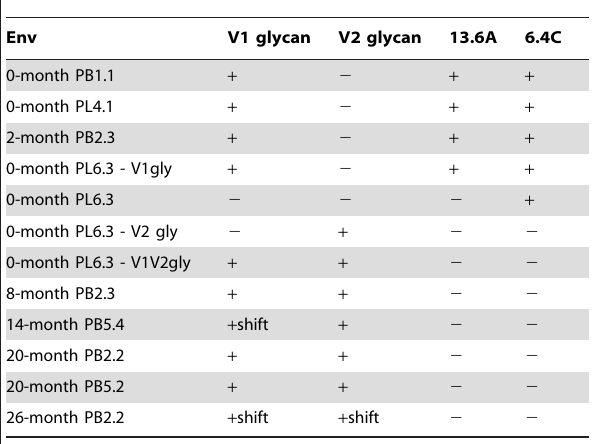
Table 2. Summary of Mab neutralization data for 205F Envs.